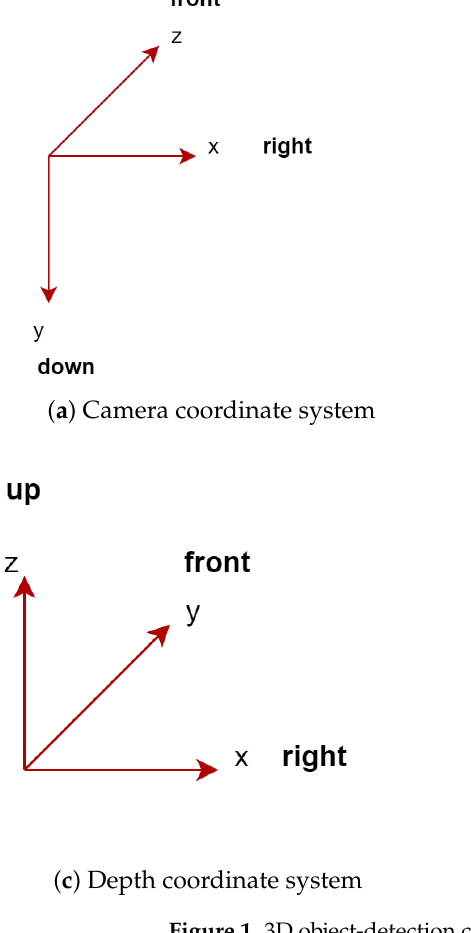
Figure 1. 3D object-detection coordinate systems. The KITTI camera coordinate system is similar to the camera coordinate system ( a ). However, its LiDAR coordinate system x -coordinate differs from the commonly used LiDAR x - coordinate system (compare ( b , d